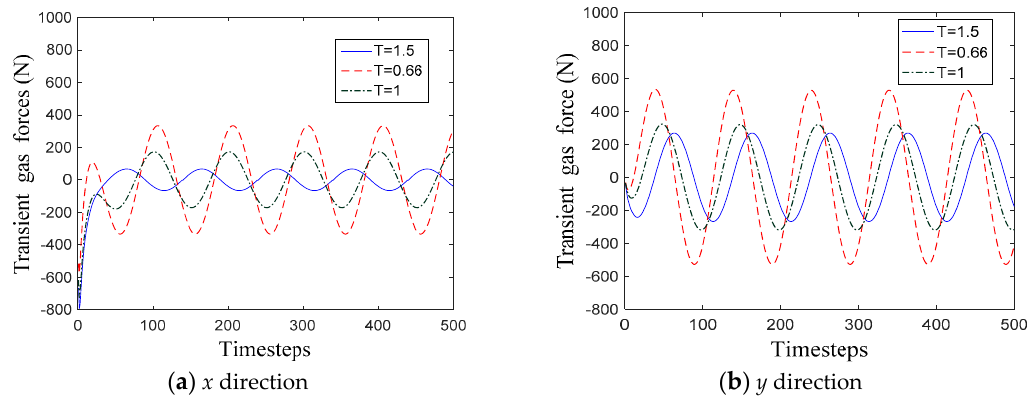
Figure 10. Transient gas forces for three taper degrees using SFWM. ( a ) x direction; ( b ) y direction.